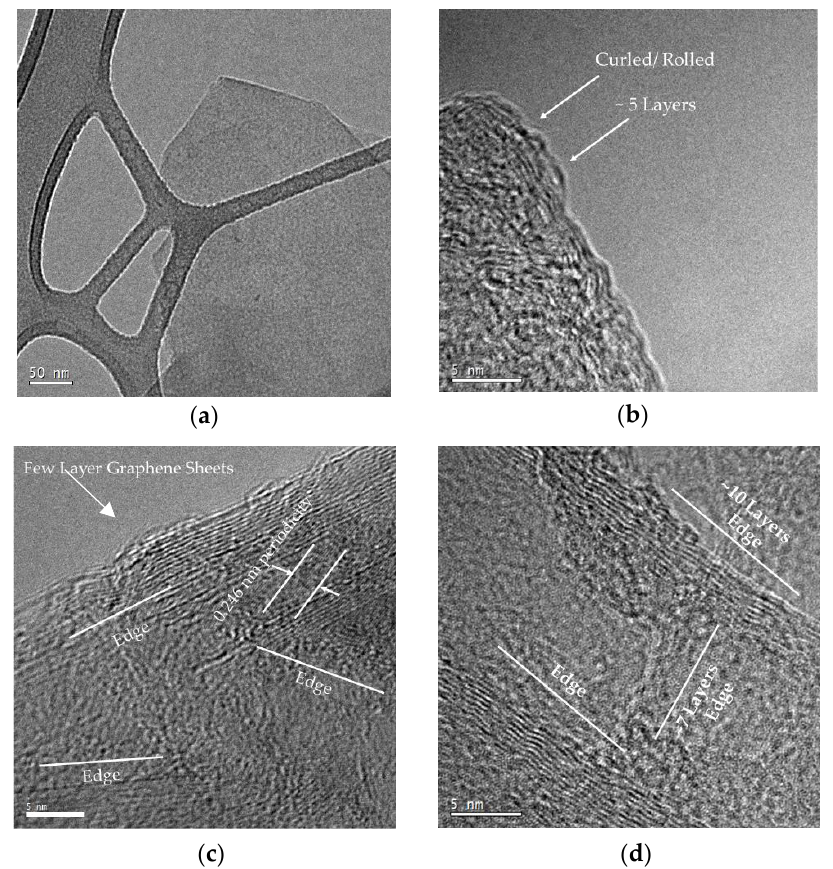
Figure 8. ( a ) Low Magnification micrograph of isolated 20 min G-PA66 flake on lacey carbon surface; ( b ) High magnification micrograph of rolled edge of many layer graphene; ( c ) High magnification micrograph of edge containing nanographite, many layer and few layer graphene; ( d ) High magnification micrograph containing many layer